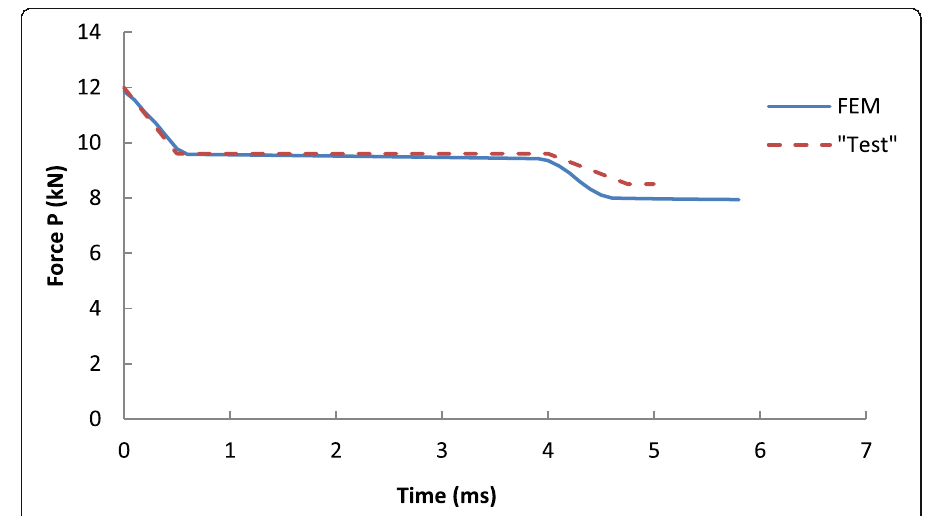
Fig. 13 Comparison between finite element and experimental testing for the velocity of trolley versus time